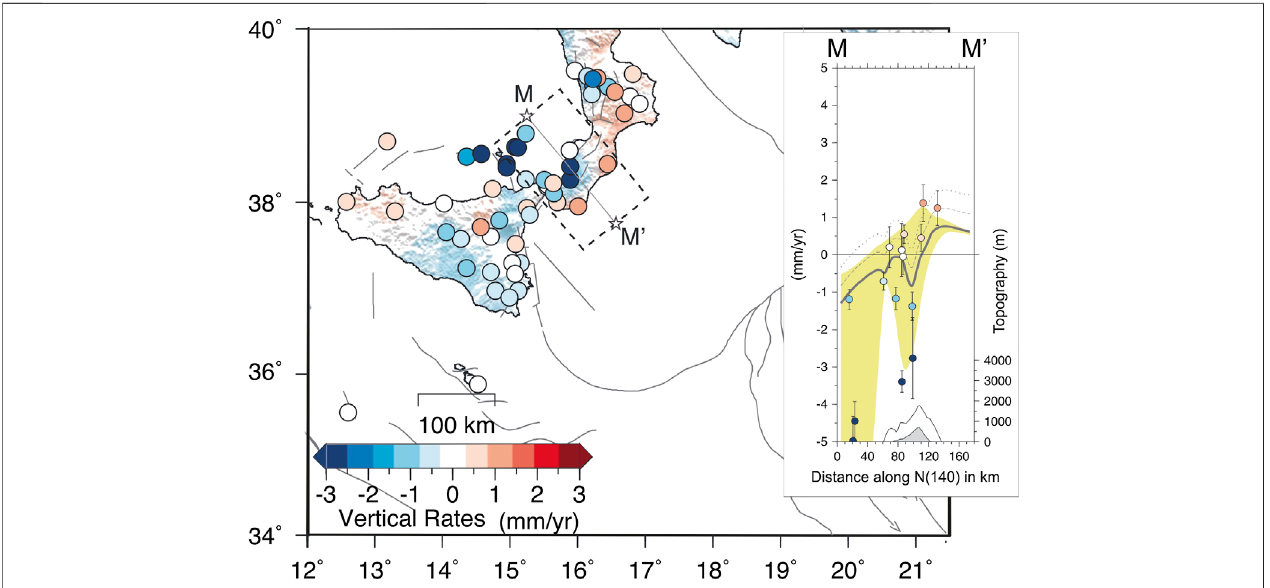
FIGURE 6 | This fi gure is redrawn from Serpelloni et al. (2013) with combination of their Figures 10 and 13. The main plot shows the observed vertical velocity fi eld (colored circles) over the Italian and surrounding regions. The color scale is saturated at ± 3 mm/yr. Positive (red) and negative (blue) values represent uplift and subsidence vertical velocities, respectively. The inset displays the vertical velocities observed along the MM ′ pro fi le shown in the main plot (southern Calabria). See Serpelloni et al. (2013) for more details.